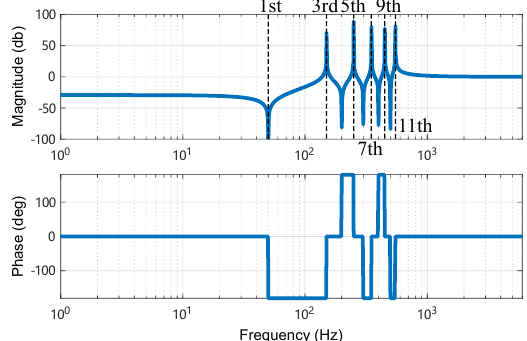
Figure 6. Frequency response of C 2,ac ( z ) with k ac = 1.